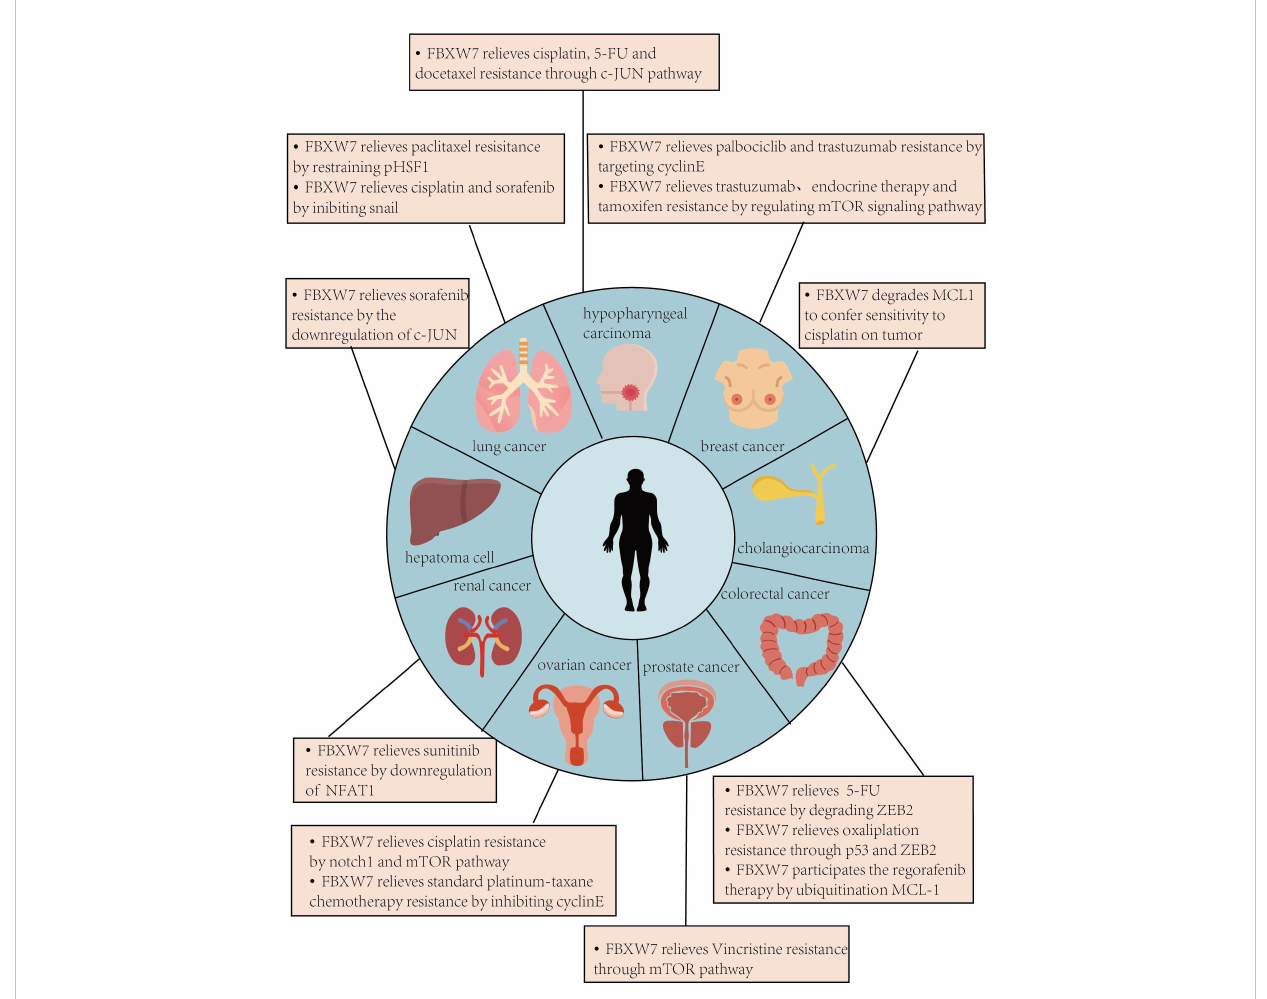
FIGURE 3 This fi gure indicates the role of FBXW7 on drug resistance in different tumors. In different tumors, the substrates of FBXW7 which take effects are not exactly the same, and the types of drugs whose sensitivity is regulated by FBXW7 also vary among different